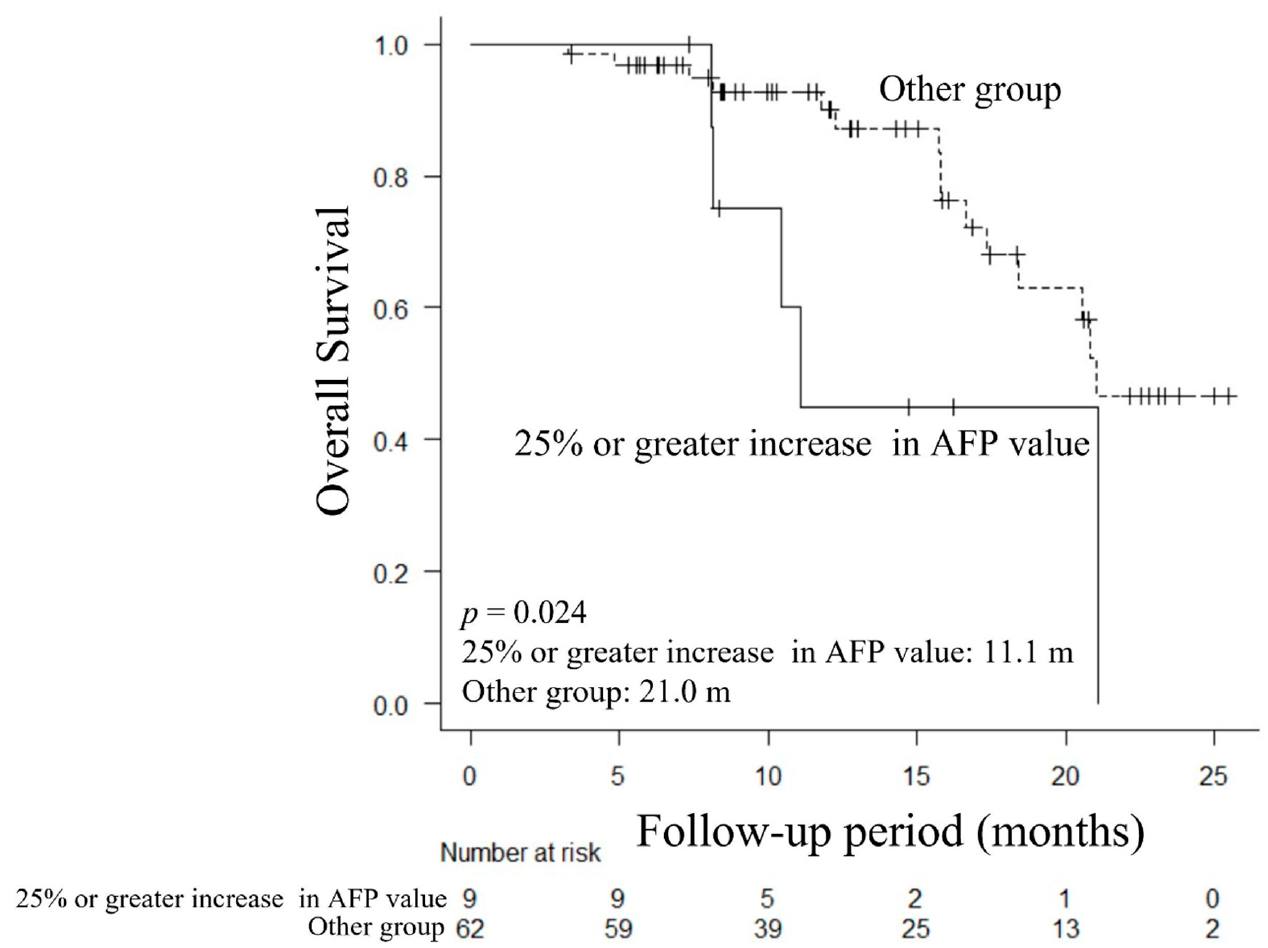
Figure 3. Comparison of overall survival (OS) between the group with a 25% or greater increase in AFP values at the first radiological response evaluation from Atezo + Beva initiation and the other group in 71 patients with SD at the first radiological response evaluation by Response Evaluation Criteria in Solid Tumors (25% or greater increase in AFP value 11.1 months, other group 21.0 months, p = 0.024).